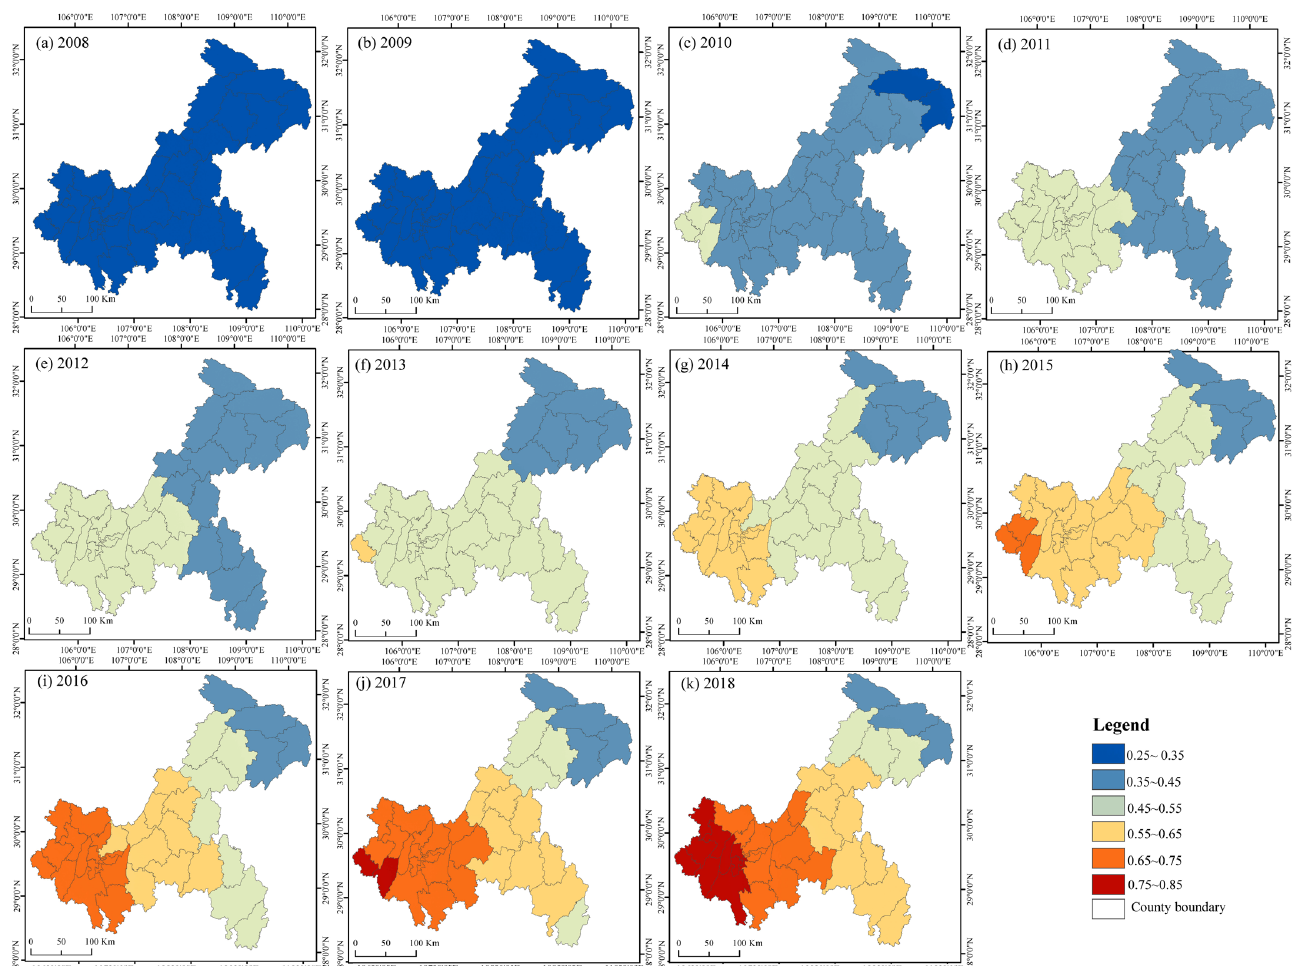
Figure 13. The spatiotemporal differences in the impacts of PU on LU. ( a – k ) The spatial distribution of the correlation coefficients of PU in GWR (2008–2018).